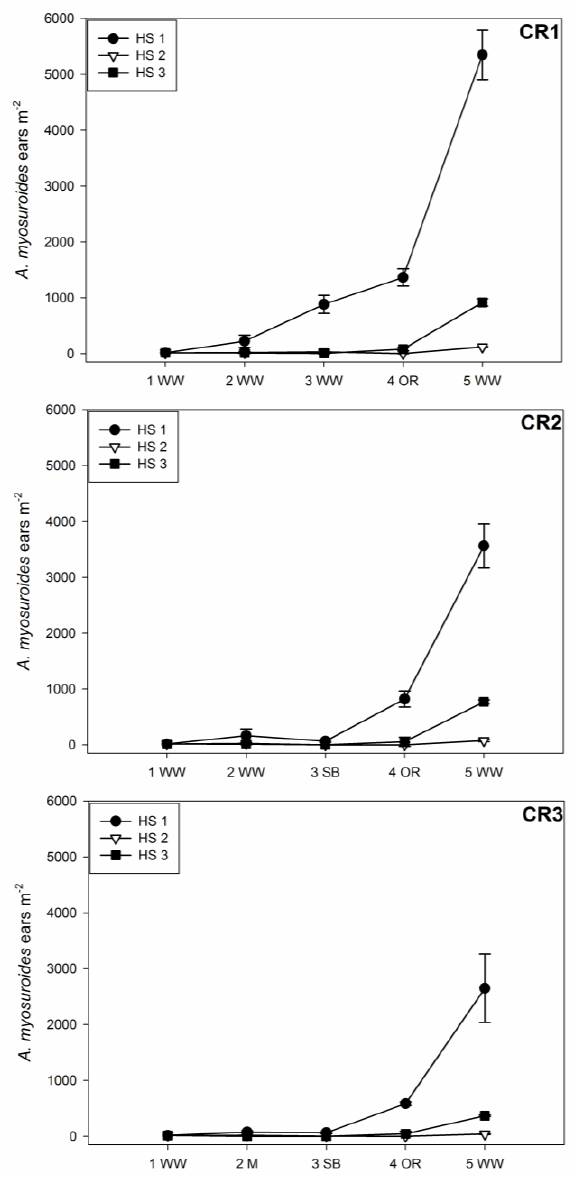
Figure 2. A. myosuroides densities expressed in ears m − 2 at the different herbicide strategies (HS) in crop rotations (CR).